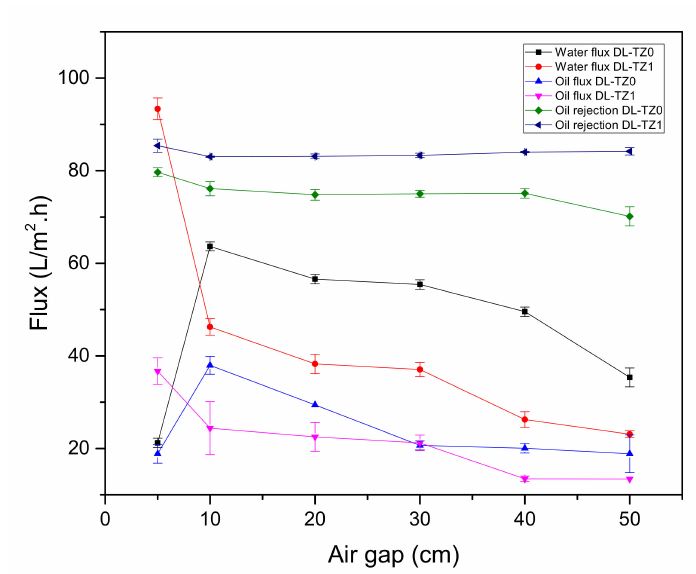
Figure 10. E ff ect of air gap on flux and oil